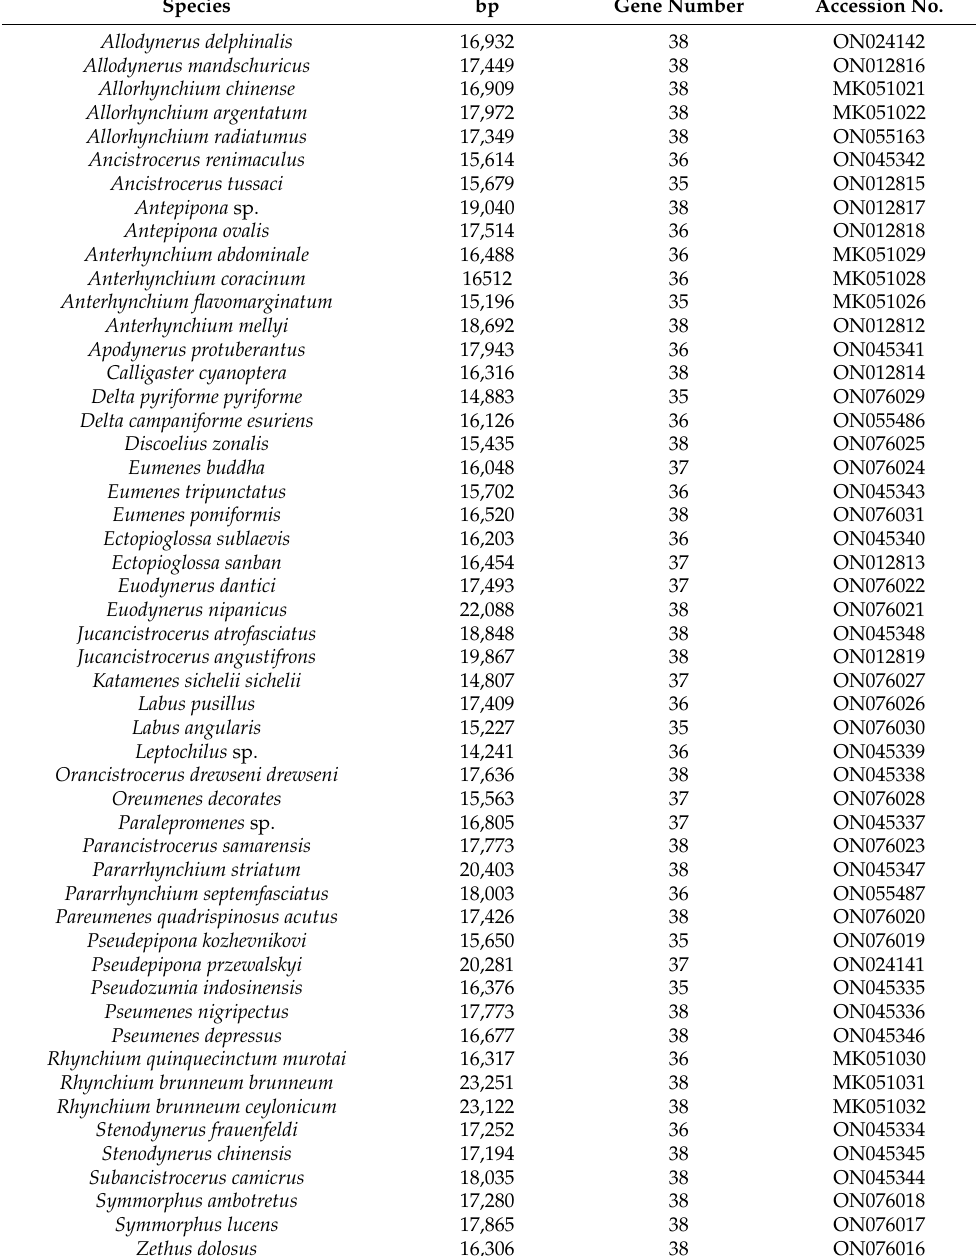
Table 1. GenBank accession numbers for mitogenomes of Eumeninae newly sequenced and annotated in this